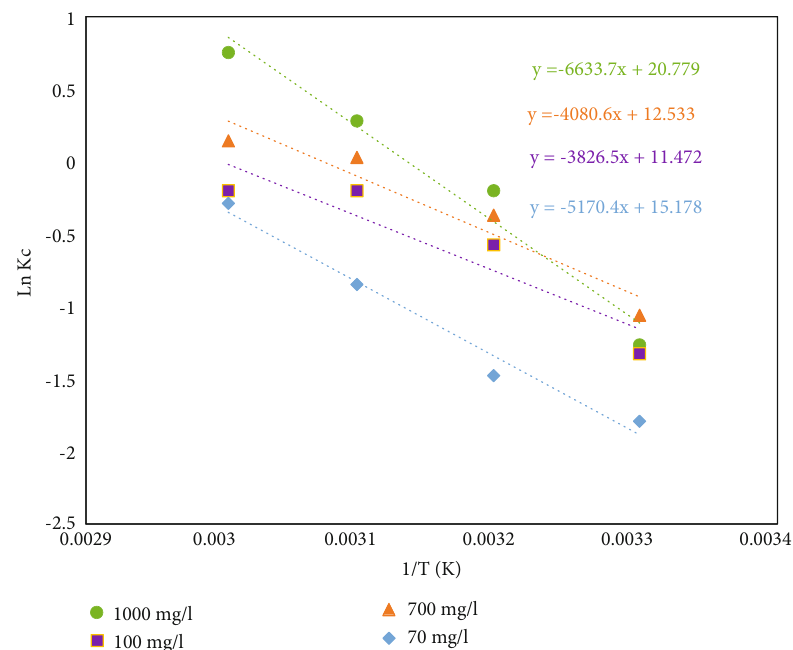
Figure 7: Linear plots of data for the thermodynamic model. Table 2: Thermodynamic model parameters. Initial Conc.